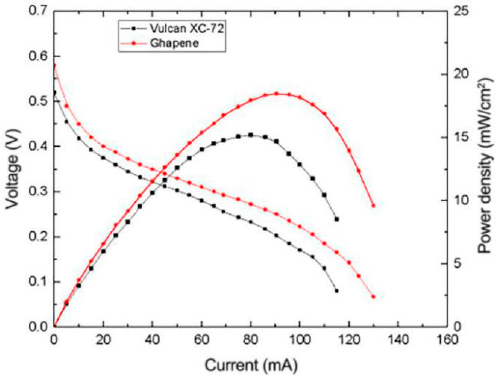
Figure 8. Effect of composition of catalytic layer on the performance of μ DMFC.